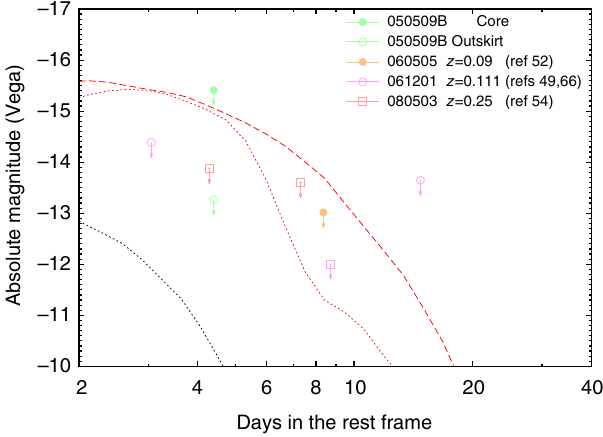
Figure 3 | Comparison of the limits of macronova in some sGRBs and theoretical models. Absolute Vega magnitudes versus rest frame time of the I-band/F814W-band observations of sGRB 050509B, hGRB 060505 (ref. 52) and sGRB 061201 (refs 49,66). The HST F814W 3 s upper limits of GRB 080503 (ref. 54) are also shown for an assumed redshift of z ¼ 0.25, following Kasen et al. 47 . It is worth noting that the Gemini i -band 3 s upper limit of sGRB 060505 was reanalysed in this work. The red dashed line is the dynamical ejecta macronova model I -band emission while the red solid line is the disk-wind ejecta macronova model I -band emission light curve, where the same model parameters in Fig. 2 are chosen. The black dotted line represents the macronova I -band emission expected for a double neutron star merger 14 with M ej ¼ 0 : 01 M (cid:2) and V ej B 0.1 c , implying that the 3 s upper limits reported in sGRB 050509B, hGRB 060505 (ref. 52) and sGRB 061201 are not deep enough to exclude the compact object merger